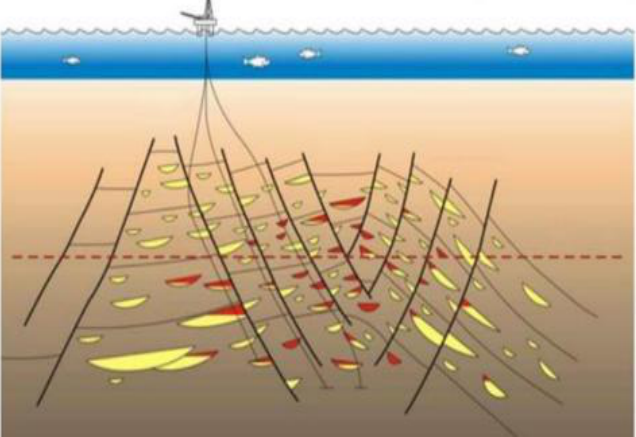
Figure 1—Reservoir structur e and complexity in the North Malay Basin.